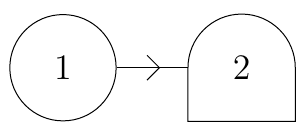
Figure 2 . The quiver representation of the SU(2)[1,1] surface